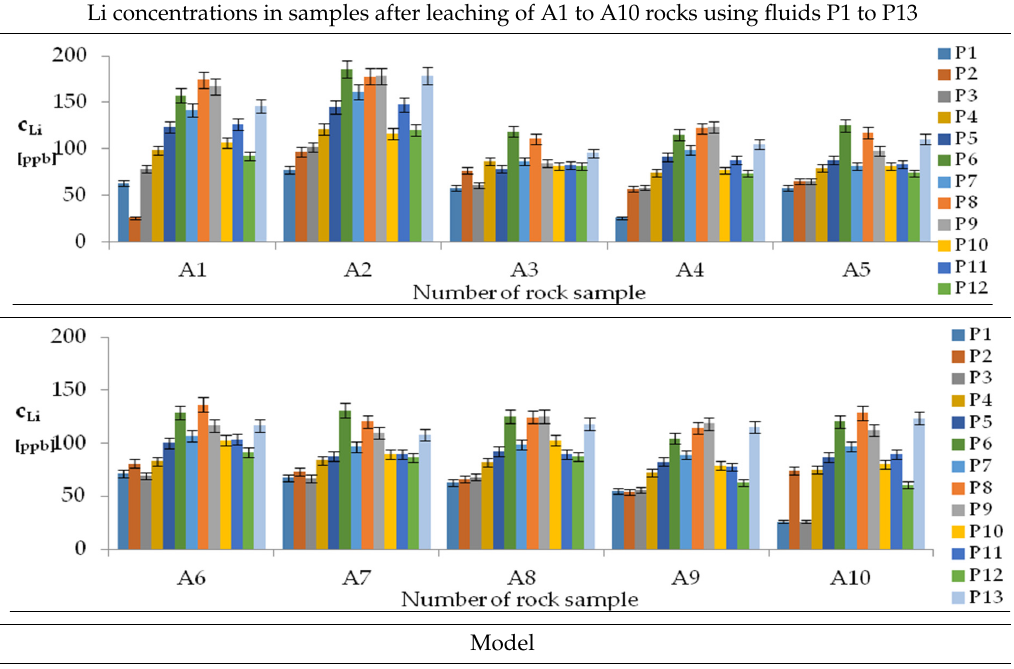
Table 10. Results of leaching samples A1 to A10 rocks using fluids P1 to P13 for Lithium (Li). Li concentrations in samples after leaching of A1 to A10 rocks using fluids P1 to P13